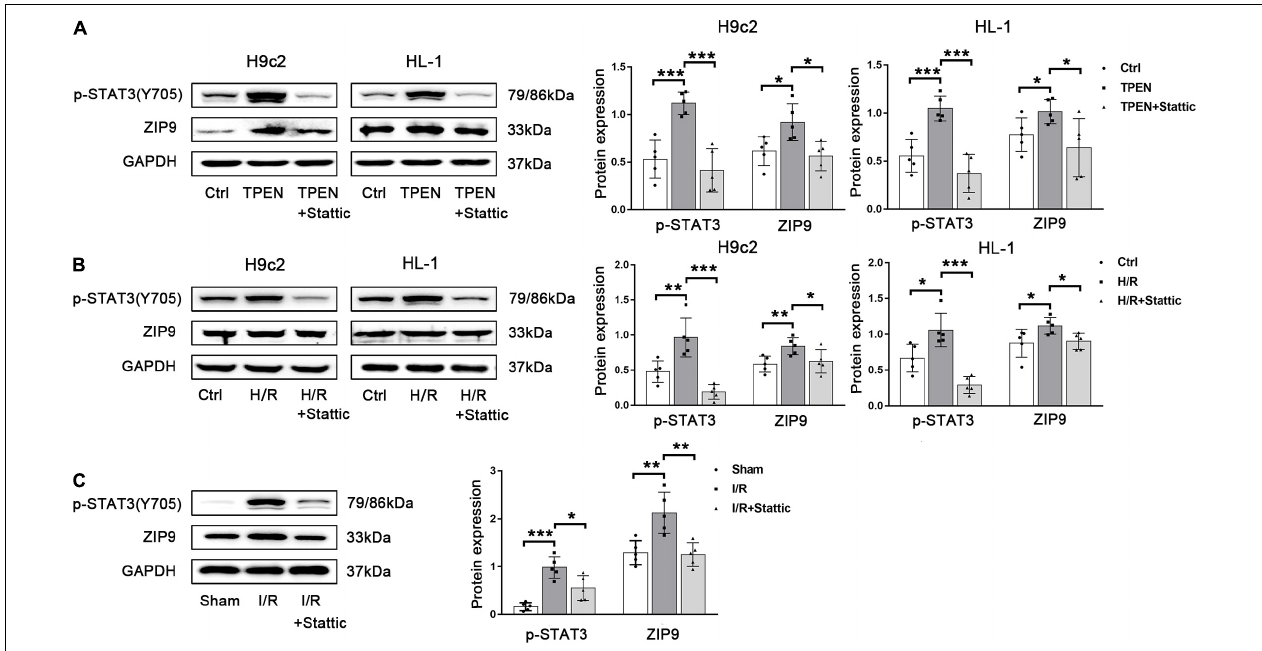
FIGURE 5 | Zinc deficiency-induced STAT3 activation promotes ZIP9 expression. (A,B) Stattic (10 µ M, n = 5) was applied 2 h before exposure to TPEN for 2 h or 30 min before the onset of reoxygenation. (C) Mouse hearts were ischemic for 30 min and then reperfused for 30 min. Stattic (3 mg/kg, n = 5) was injected 5 min before reperfusion and continued for 30 min through the tail vein. * p < 0.05, ** p < 0.01, and *** p <